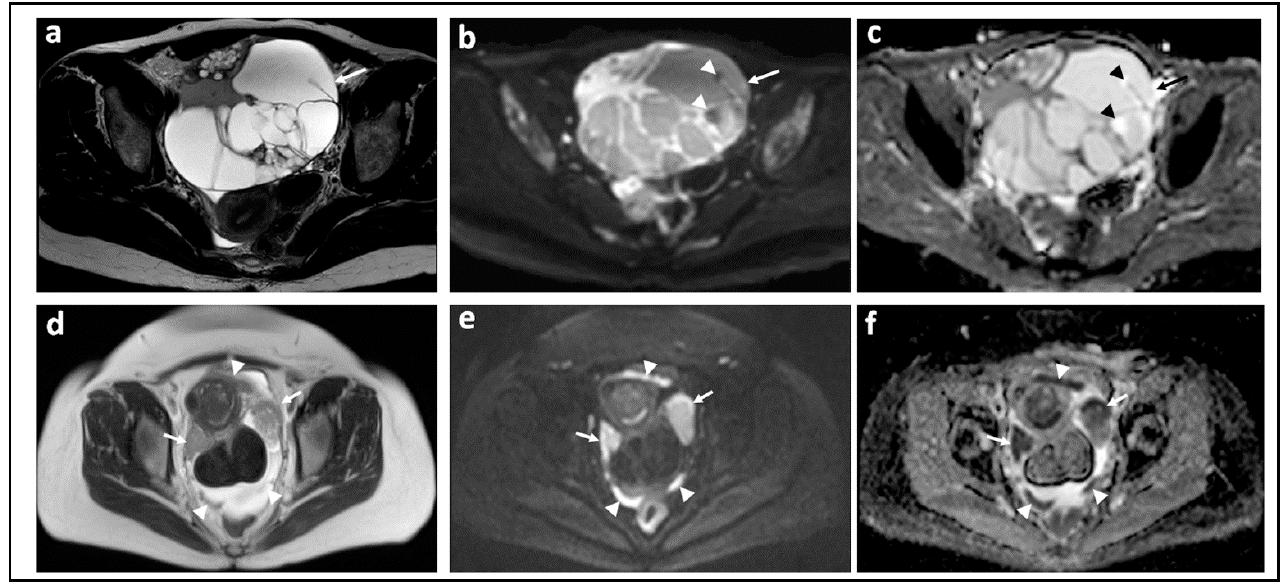
Figure 2. Borderline versus malignant ovarian tumor: T2-W image ( a ) and corresponding b = 1000 s/mm 2 DW-MRI ( b ) and ADC map ( c ) through the mid-pelvis in a patient with a mucinous borderline tumor of the left ovary. There is a large multiloculated cystic mass with no significant solid components (arrows). Two small foci of low signal in ( b ) show no evidence of diffusion restriction in c (arrowheads). In comparison, the T2-W image ( d ), b = 900 s/mm 2 DW-MRI ( e ), and ADC map ( f ) in a patient with invasive high grade serous ovarian cancer show bilateral solid irregular ovarian masses (arrows) and linear peritoneal metastases [arrowheads], all of which show marked diffusion restriction.